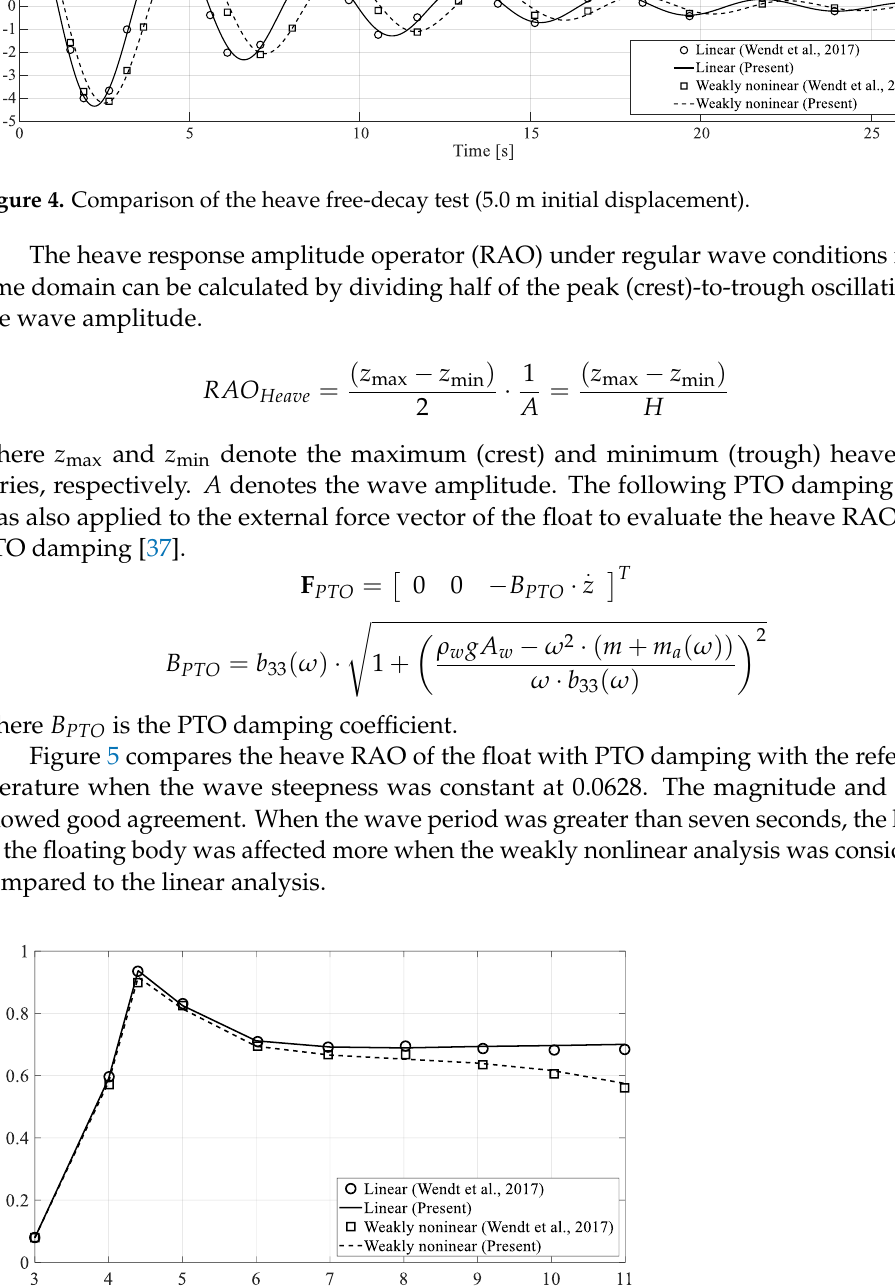
7 of 19 Figure 3. Model of a spherical float.